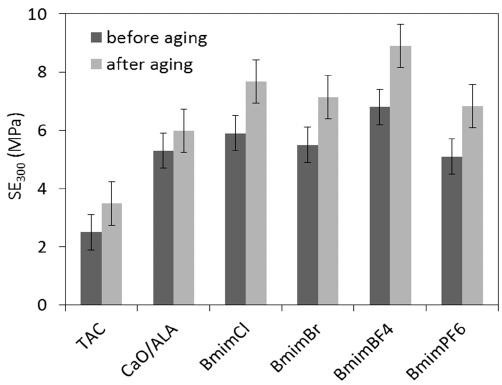
Figure 9. Crosslink densities of silica-filled EPM vulcanizates after weather aging.